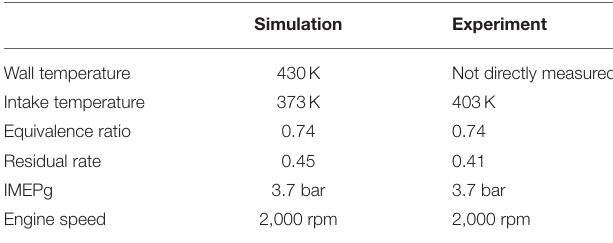
TABLE 2 | Operating condition of the validated case.